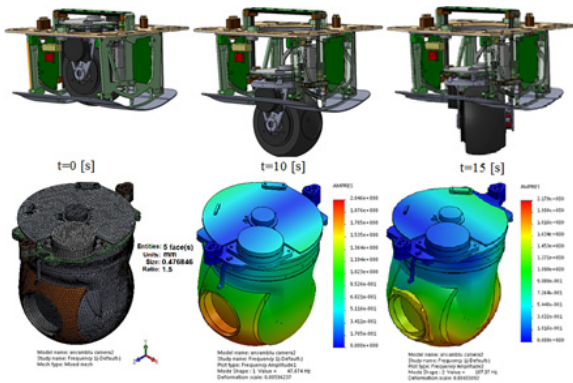
Figure 4. Processes 2020 , 8 , x FOR PEER REVIEW